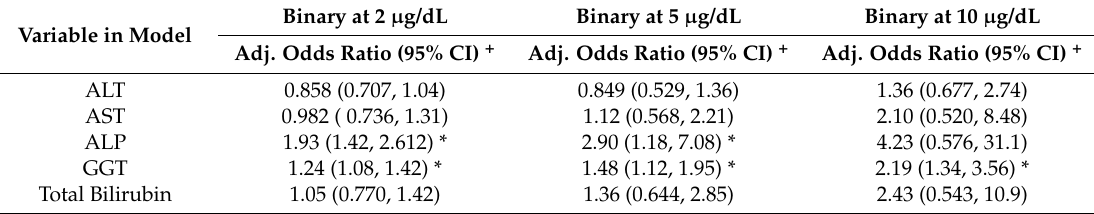
Table 6. Logistic regression analysis BLL binary at 2 µ g/dL, 5 µ g/dL, and 10 µ g/dL level.